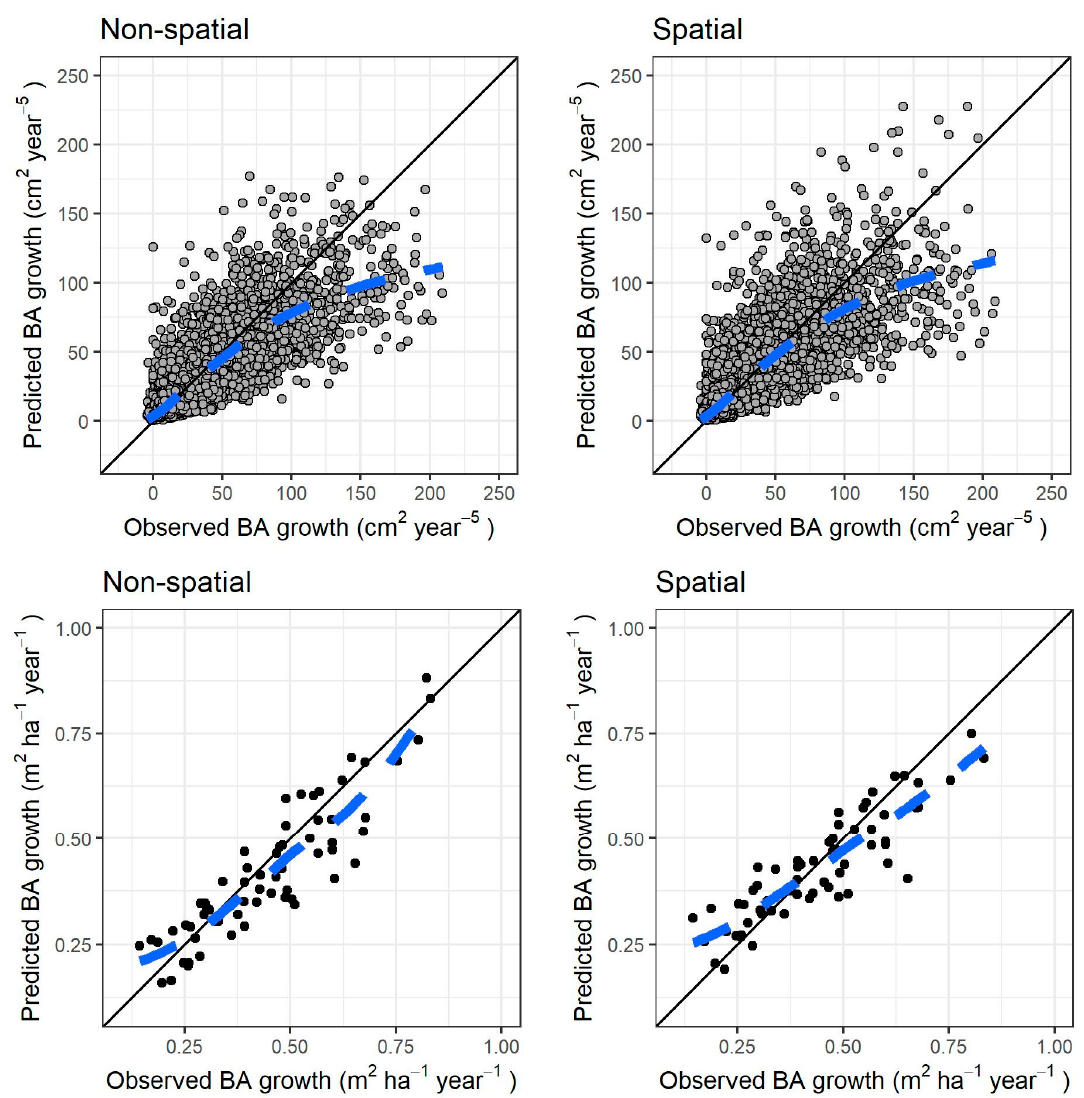
Figure 5. Cross-validation results for both models of individual tree growth ( left column ) nonspatial, ( right column ) spatial; ( top row ) fitted versus observed individual tree growth; ( bottom row ) fitted versus observed growth, both aggregated at stand level for each measurement period. The black line in all graphs shows the identity line, the dashed blue line a locally estimated scatterplot smoothing curve for the scatterplot.